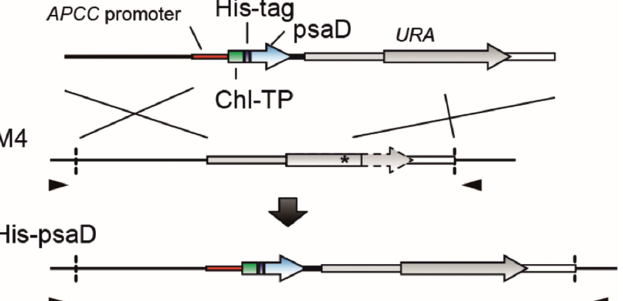
Figure 1. Characterization of the C . merolae recombinant cell lines expressing the nuclear